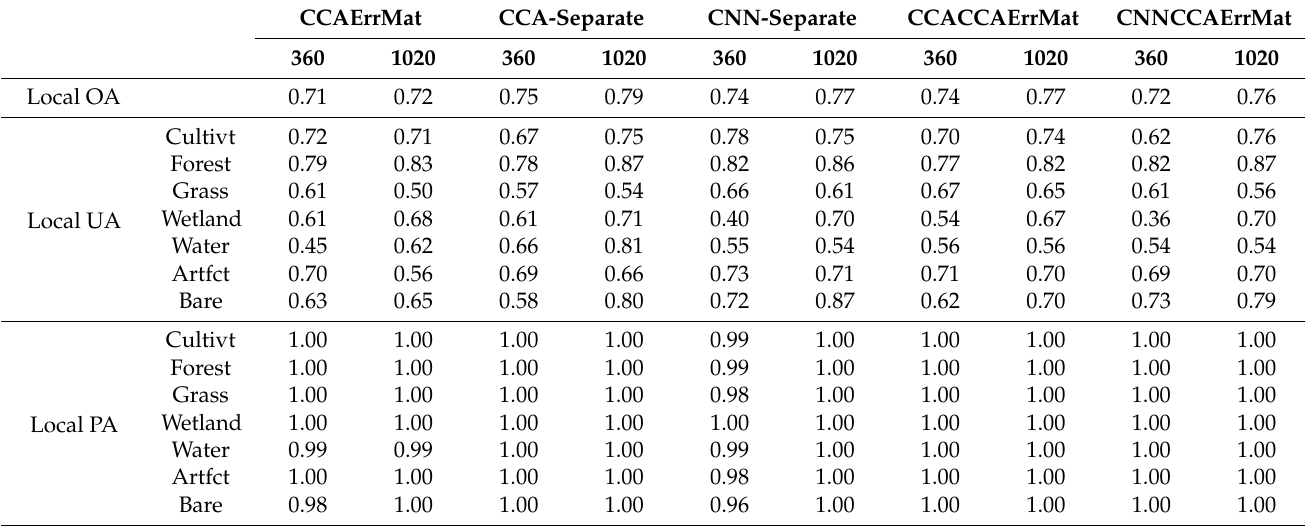
Table 2. AUC-based evaluation for local accuracy